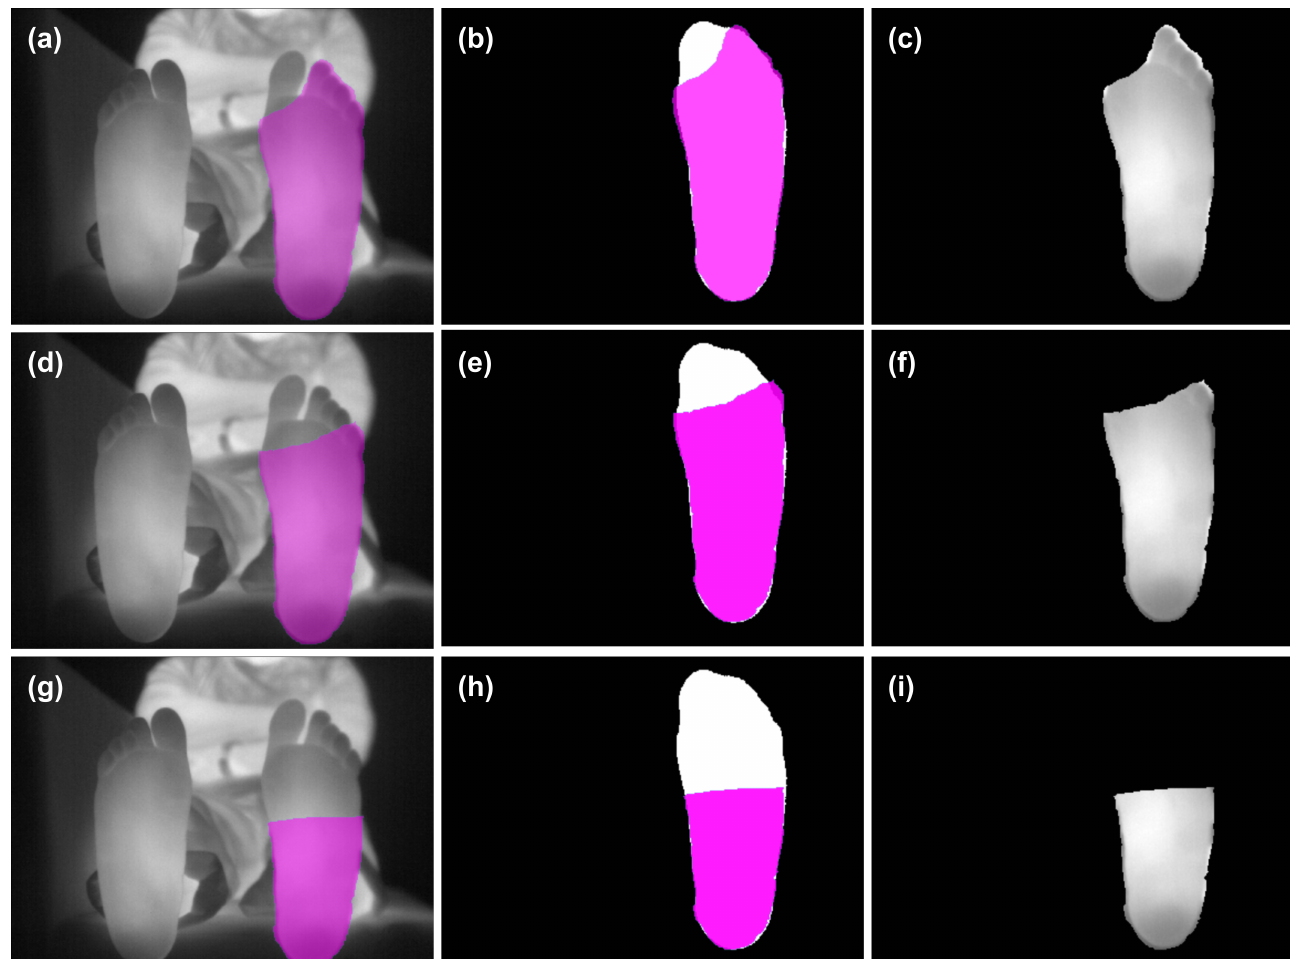
Figure 4. Three different configurations for partial foot amputation are displayed; each row corresponds to the same case and each column to the subsequent steps within the workflow described in Figure 2. The first column, ( a , d , g ), displays the original IR images and the overlapped segmentation (pink mask) in which various degrees of partial foot amputations have been simulated. The second column, ( b , e , h ), shows the simulated segmentation (pink mask) registered to and overlapped with the corresponding left foot model. The third column, ( c , f , i ), illustrates the final result where the simulated segmentation is applied to the original IR image for further